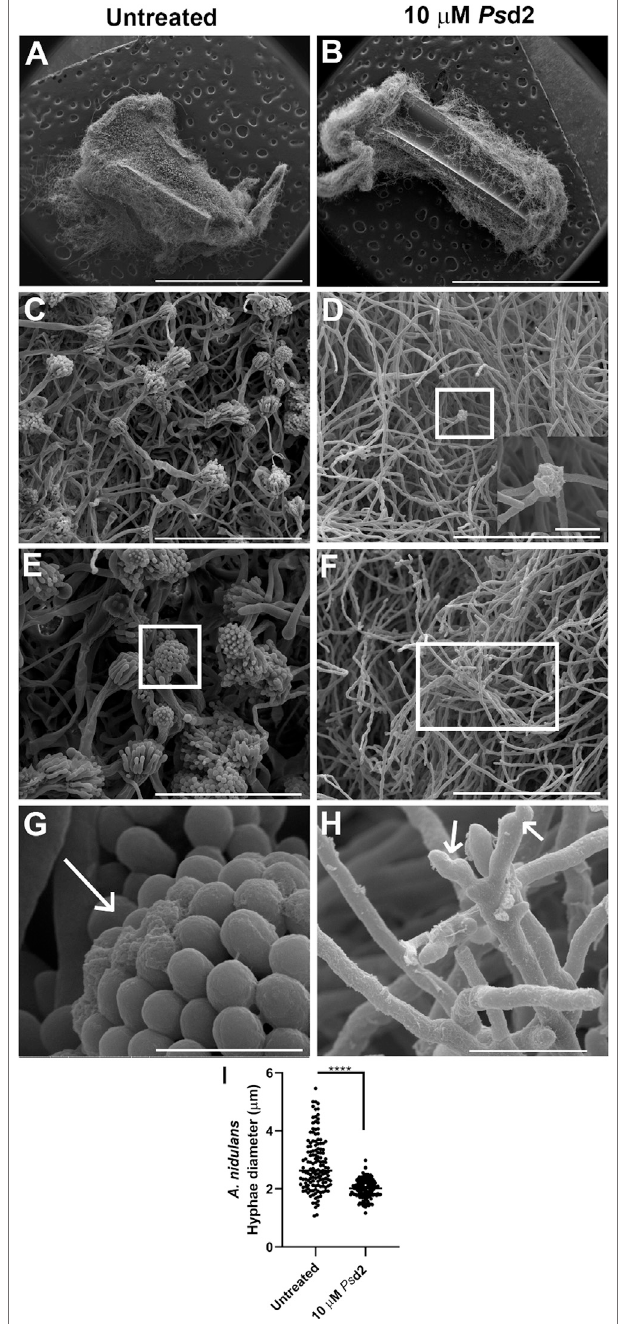
FIGURE 6 | Scanningelectronmicrographsofultrastructuralchangesin A. nidulans bio fi lms induced by Ps d2 defensin. A. nidulans bio fi lms were grown in YUU medium for 24 h at 37 ° C in CVCs in the absence (A,C,E,G) or presence of 10 µM Ps d2 (B,D,F,H) . The inset zoom image is at 12000 × magni fi cation (D) and represents a deformed conidiophore in the bio fi lm treated with 10 µM Ps d2.ThewhitearrowsrepresentECMaccumulatedintheconidiophore (G) and deformedhyphae (H) .Scalebarsrepresent3 mm (A,B) ,100 µm (C,D,F) ,50 µm (E) , 10 µm ((H) , inset zoom image), 5 µm (G) . Hyphae diameter (I) of the untreated and treated bio fi lms was measuredusing ImageJ software.Signi fi cant differences ( p < 0.05) are represented by asterisks; **** p < 0.0001.